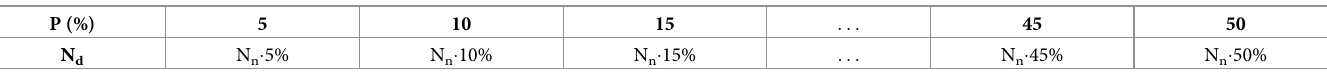
Table 1. Number of damaged